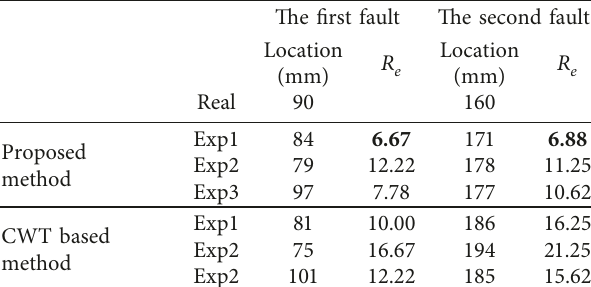
Table 4: Fault location